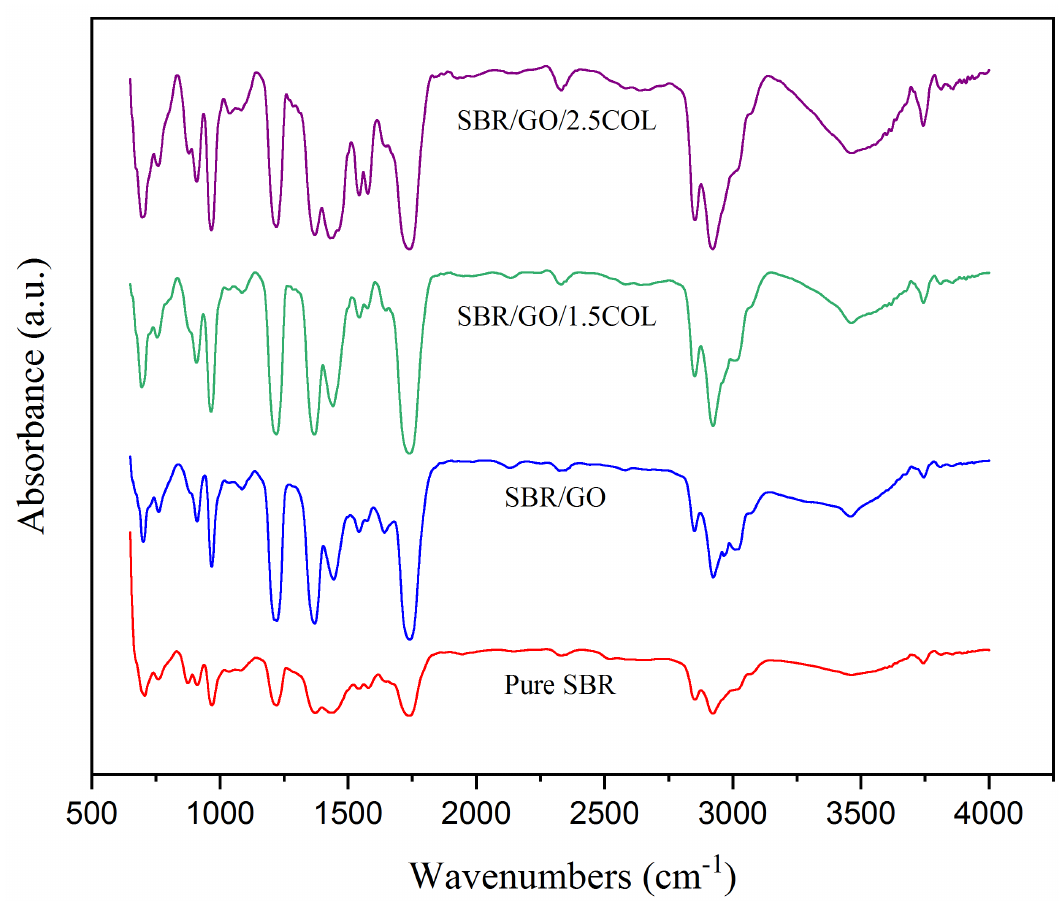
Figure 4. FTIR spectra of SBR